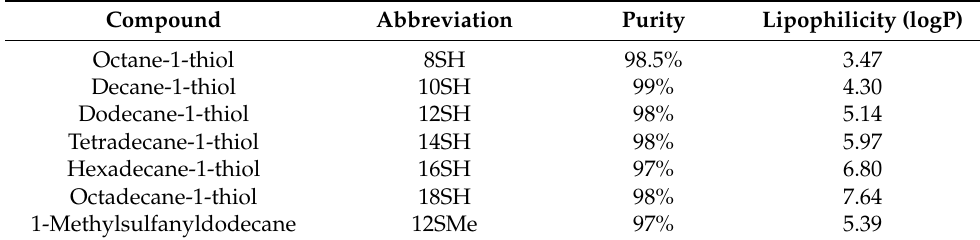
Table 1. Selected properties of the thiols and thioethers investigated in this